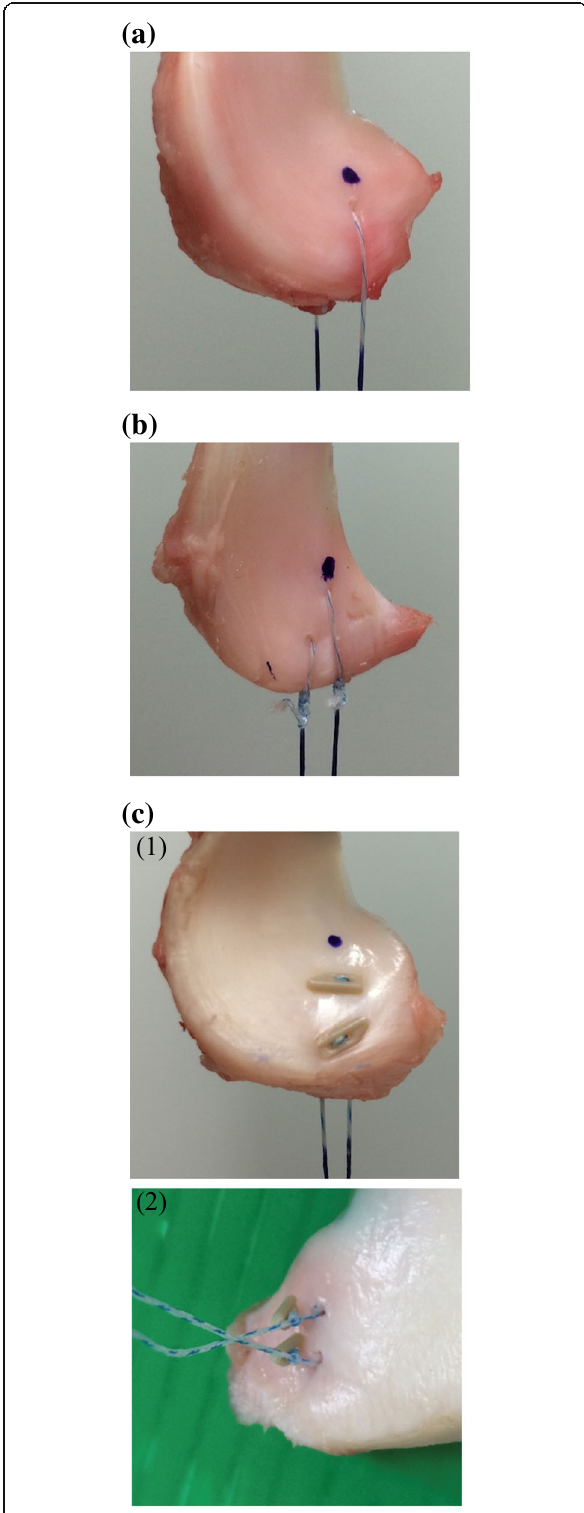
Fig. 2 Set-up for biomechanical testing. The sutures stitched the anterior horn were fastened to the upper clamp. The sutures introduced to the posterior horn were tightened over the metal